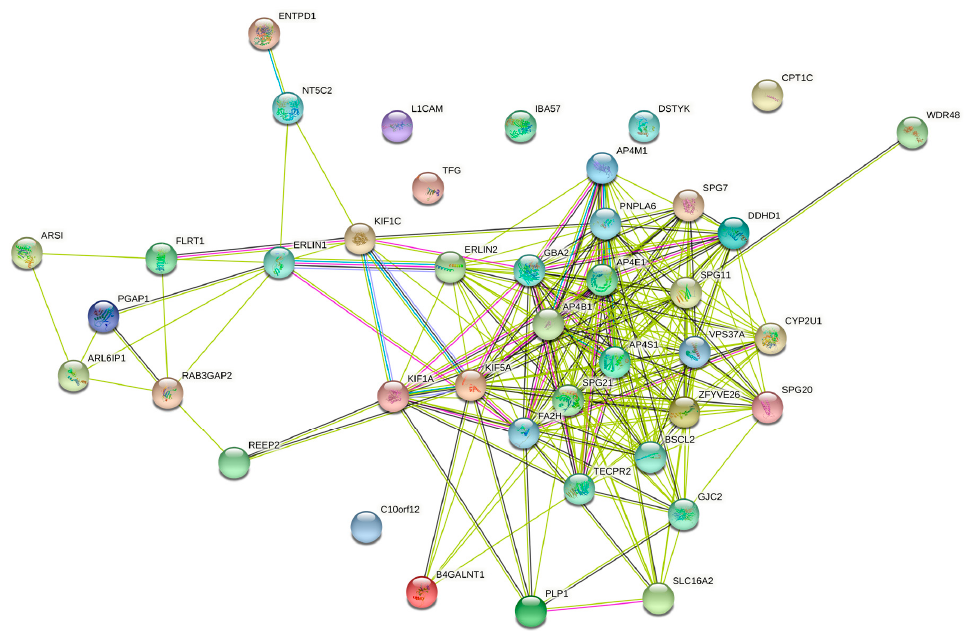
Figure 4. Predicted PPI networks direct interactions among 42 genes of complicated